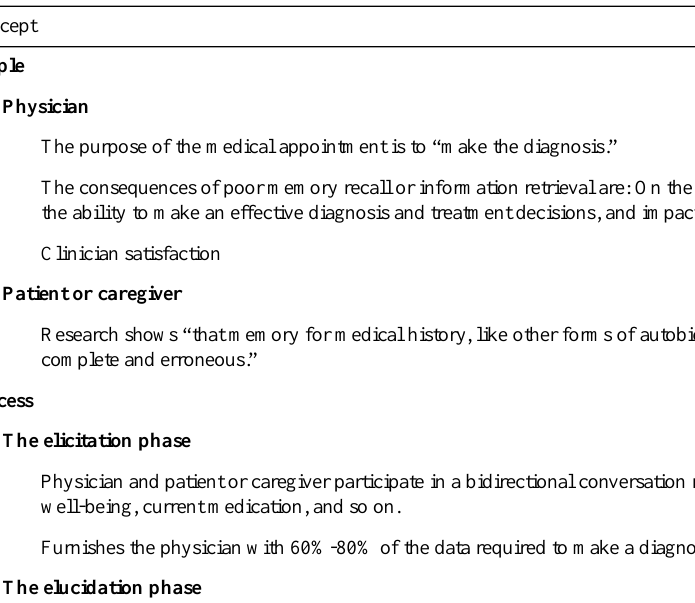
Table 1. People, process, technology, and data model